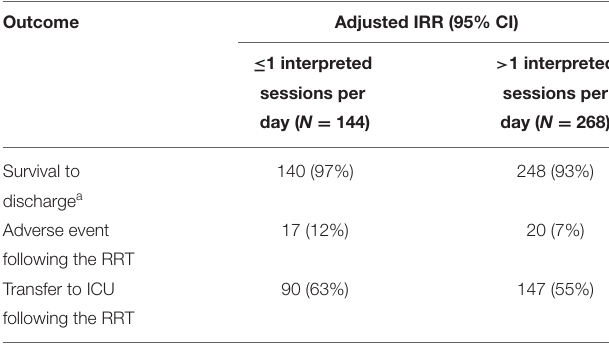
TABLE 3 | Results of adjusted and unadjusted Poisson regression models associating language use with each measured outcome. Outcome Unadjusted